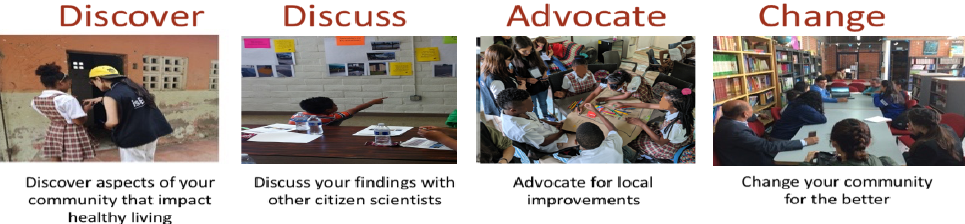
Figure 2. The 4-step Our Voice citizen science model. © Stanford University. All rights